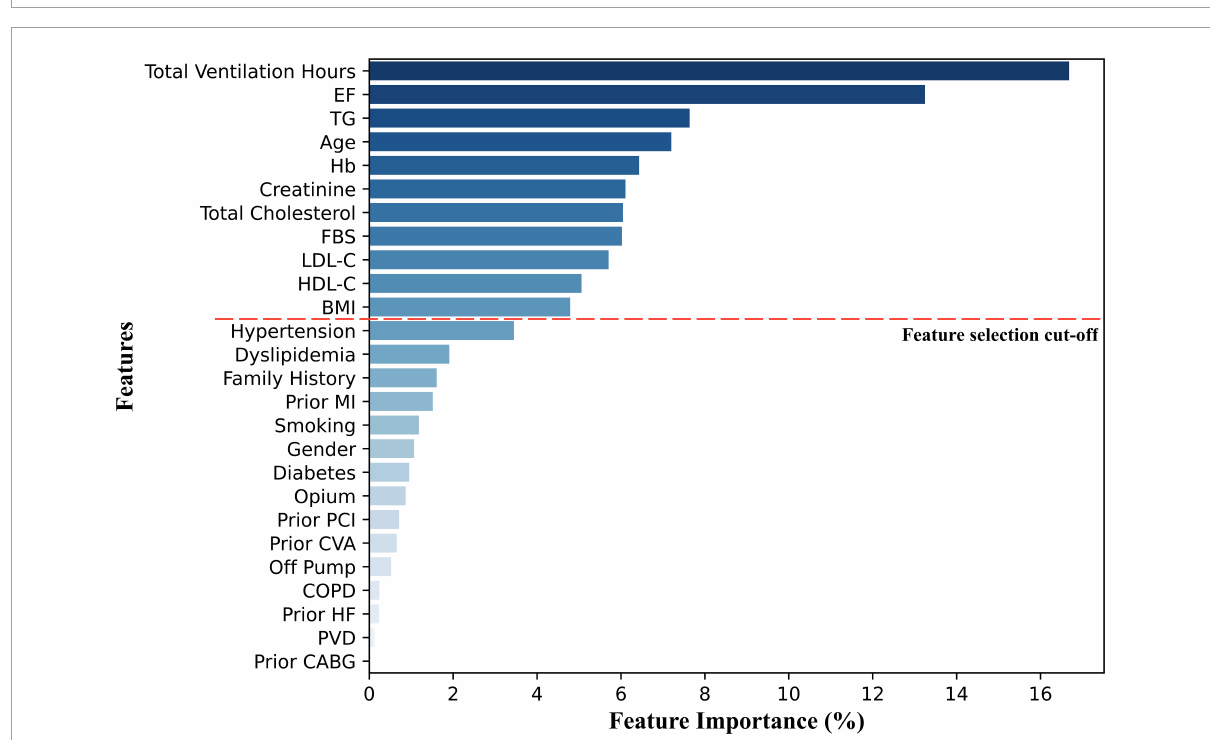
FIGURE3 Feature importance based on the Random Forest model. MI, myocardial infarction; HF, heart failure; COPD, chronic obstructive pulmonary disease; CABG, coronary artery bypass grafting; PCI, primary cutaneous intervention; PVD, peripheral vascular disease; CVA, cerebrovascular accident; FBS, fasting blood glucose; LDL-C, low-density lipoprotein cholesterol; HDL-C, high-density lipoprotein cholesterol; TG, triglyceride; BMI, body mass index; Hb, hemoglobin; EF, ejection